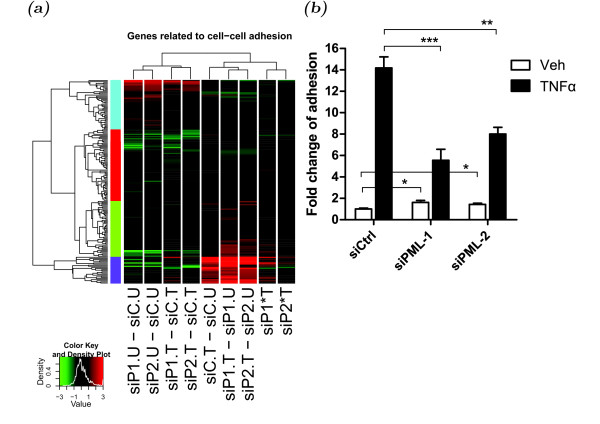
The effects of PML knockdown and/or TNFα on leukocyte:HUVEC adhesion. (a) Clustering analysis of the log change fold values of the coregulatory network of genes significantly affected by PML knockdown and/or TNFα signaling. Using dynamicTreeCut R package as described in Methods, 4 sub-clusters of significantly altered genes were identified and annotated by color side bars (blue, red, green and purple respectively). Control siRNA, “siC”; two PML siRNAs, “siP1” and “siP2”; vehicle treated samples, “U”; TNFα treated samples, “T”; minus sign of “-”, comparison between two samples; sign of “∗”, interaction effects. (b) Quantification of the adherence of human leukocyte U937 cells on HUVECs transfected with control siRNA (siCtrl) or two independent PML siRNAs (siPML-1 and siPML-2) without or with TNFα treatment. Two-tail unpaired t-tests: ∗, p < 0.05; ∗∗, p < 0.01; ∗∗∗, p < 0.001.